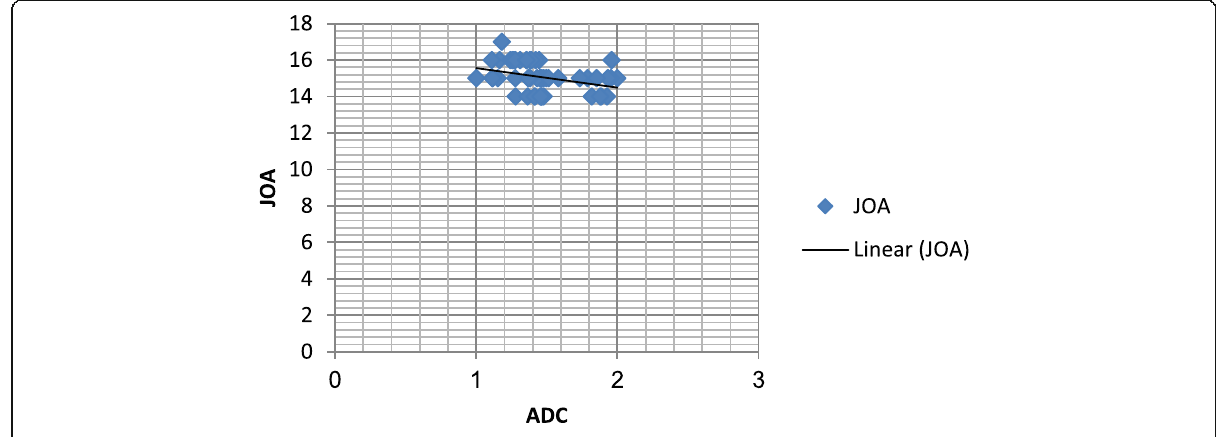
Fig. 3 Correlation between ADC and JOA scores for compressed nerves